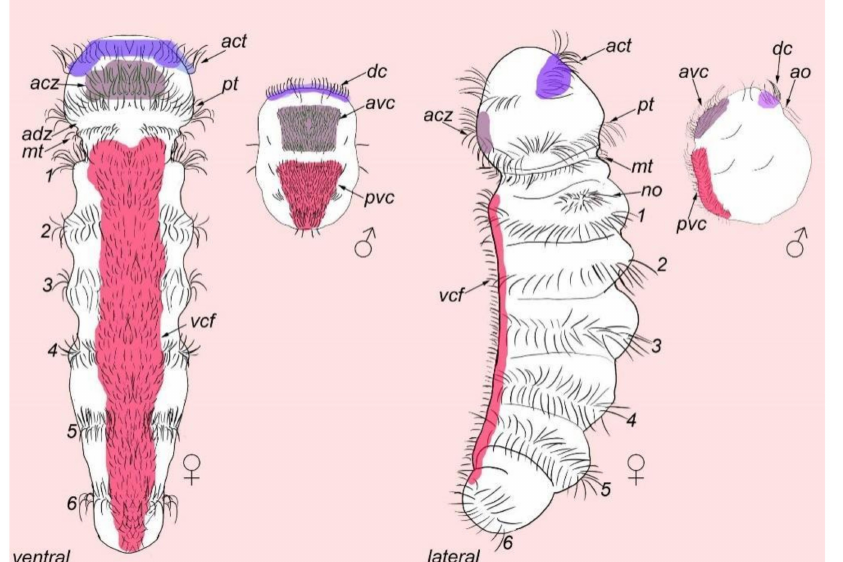
Figure 12. Comparative diagram of the external ciliation and possible homology regions on D. gyrociliatus male and female. The diagram is based on recent data on D. gyrociliatus female [14] and male (this study) external ciliation and male. Female acrotroch and male dorsal cilia, anterior ciliary field in female ad anterior ventral cilia in male, ventral ciliary field in female and posterior ventral cilia in male seems to be homologus structures. The apical end is up. Relative dimensions are not to scale. Abbreviations: act —acrotroch; acz —anterior ciliary field; adz —adoral ciliary zone; avc —anterior cilia; dc —dorsal cilia; mt —metatroch; pvc —posterior cilia; test —testis; co —copulatory